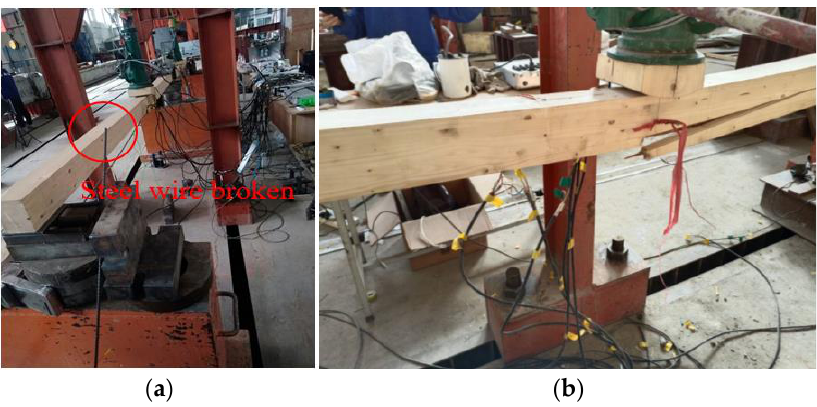
Figure 12. Fracture of steel wire. ( a ) Wire breaking; ( b ) Beam bottom tearing.